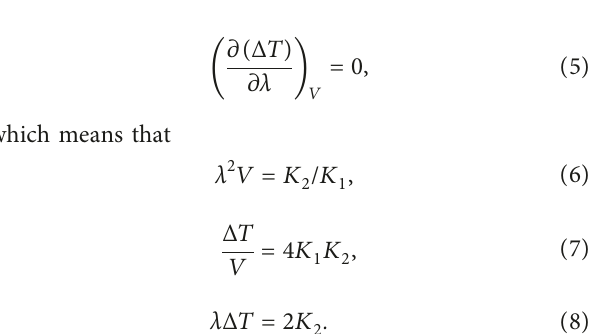
Figure 9: Schematic drawing of the solidification